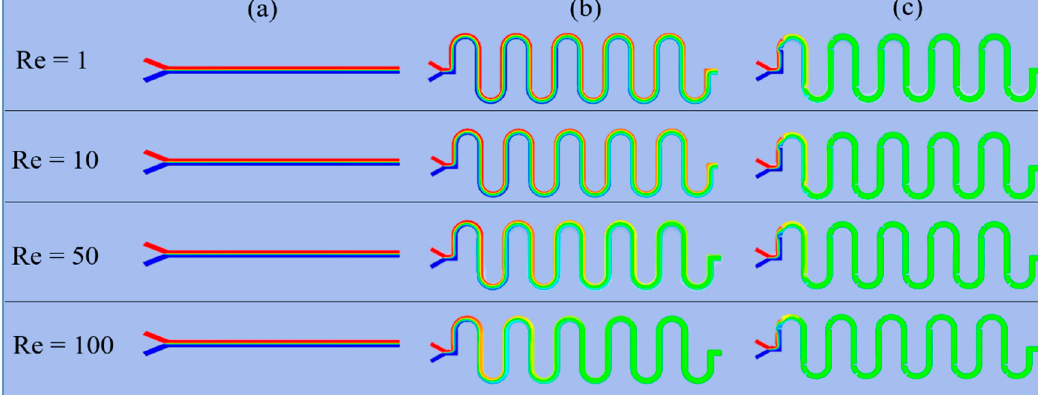
Figure 2. Numerical concentration distribution results of two-phase mixed fluid flow within each micromixer in the x–y plane for different Re numbers ( Re = 1, 10, 50, 100): ( a ) Y-shaped, ( b ) S-shaped, and ( c ) S-shaped with embedded baffle. Red, corresponding to Vf = 1, denotes that the microchannel is full of the red-colored solution at the specified point. Blue, corresponding to Vf = 0, denotes that the microchannel is full of the blue-colored solution but no red-colored solution. Green represents complete mixing of the two-phase fluid, with Vf = 0.5.